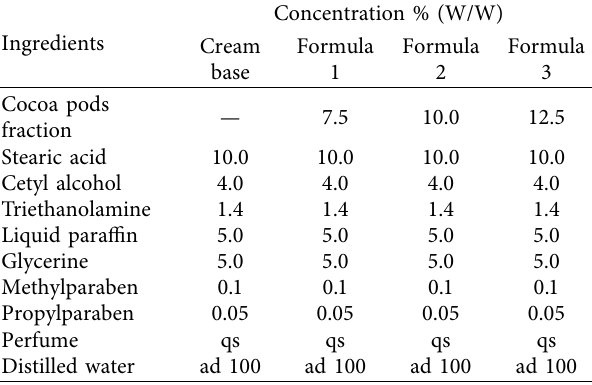
Table 1: Cream formulation of cocoa pods.